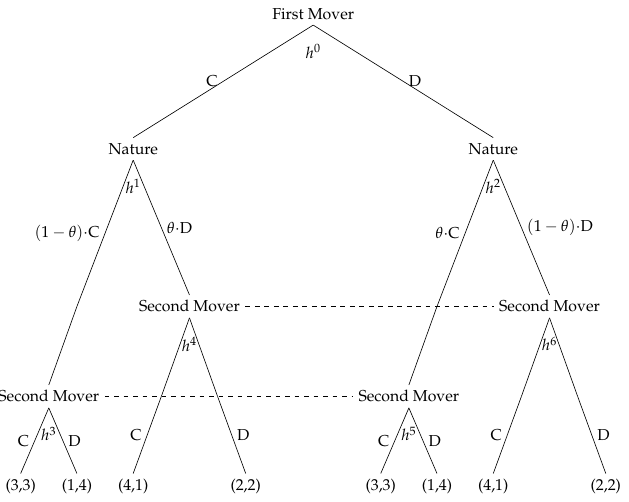
Figure 2. Sequential Prisoner’s Dilemma with Nature and Imperfect